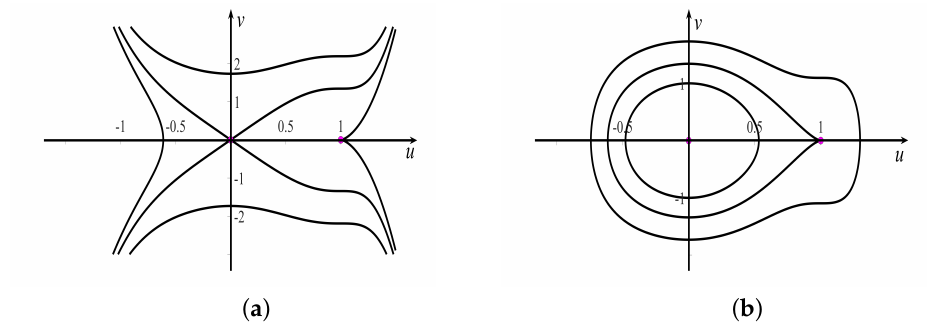
Figure 2. Global phase portraits of system (12) in Case 2: ( a ) A = 8; ( b ) A = −